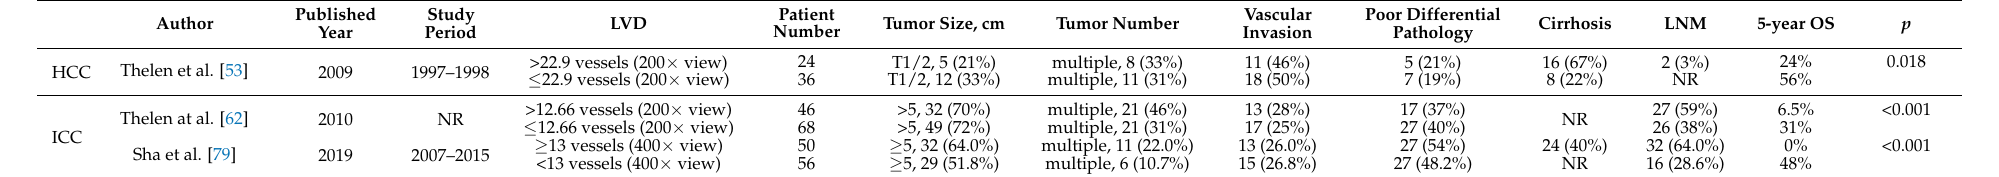
Table 1. Studies evaluating lymphangiogenesis in liver cancer.